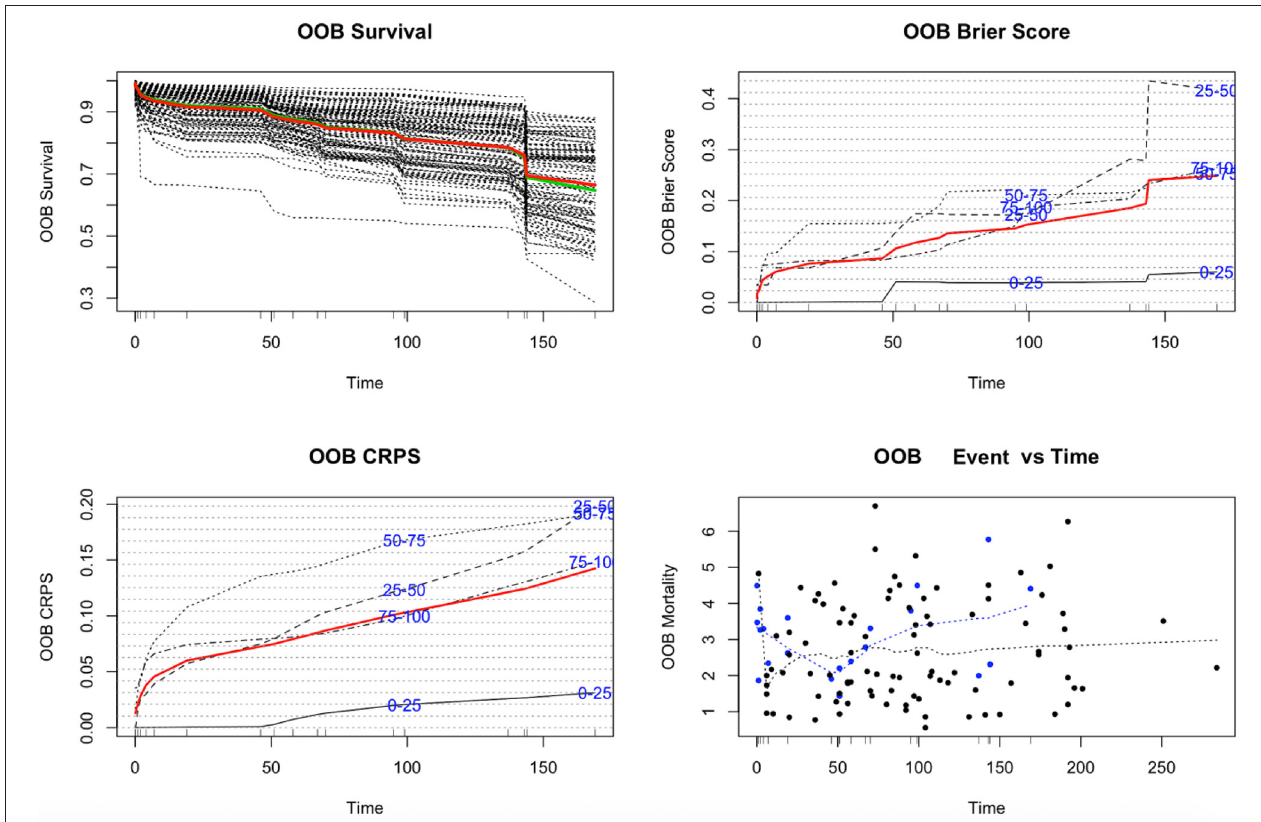
FIGURE 4 | Survival estimates. Survival function estimated for each LQTS patient from the random survival forest (RSF) model (overall ensemble survival is indicated by the red line; the Nelson-Aalen estimator is given by the green line) (top left ). Brier score (0 = perfect, 1 = poor, and 0.25 = guessing) stratified by ensemble spontaneous VT/VF based on the inverse probability of censoring weight (IPCW) method (top right ). The cohort was stratified into four groups of 0–25, 25–50, 50–75, and 75–100 percentile spontaneous VT/VF (the overall, non-stratified, Brier score is shown by the red line). Continuous rank probability score (CRPS) given by the integrated Brier score divided by time (bottom left ). Plot of spontaneous VT/VF of each LQTS patient against time (bottom right ). Events are shown as blue points, whereas censored observations are shown as black points.